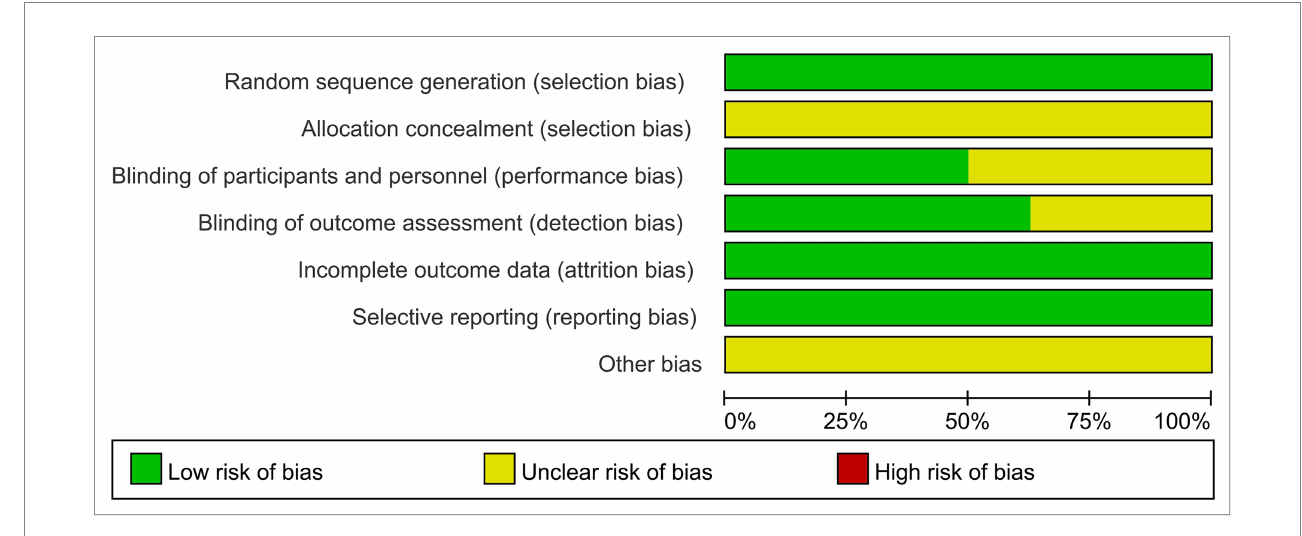
FIGURE 2 Risk assessment of